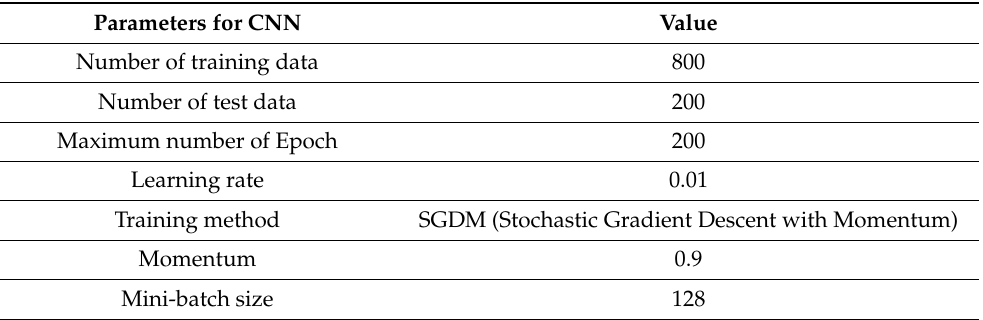
Table 5. Parameters for CNN simulation.